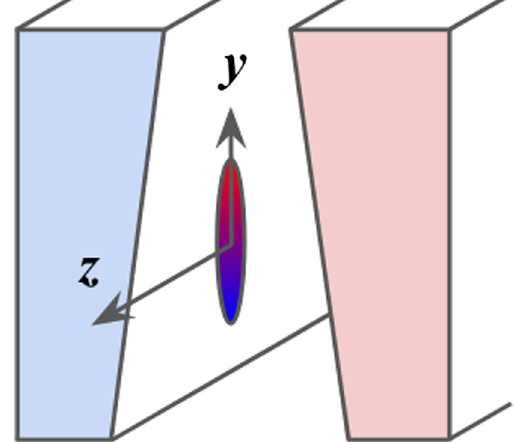
above.FIG. 1. Cross section of a transverse gradient undulator (TGU) aligned vertically. The direction of electron motion is in z . The magnetic field gradient grows stronger along the positive y axis due to the canted undulator poles (exaggerated for visibility). If the electron bunch (center oval) is dispersed appropriately so that higher energy electrons (red; top half) experience higher field strength while lower energy electrons (blue; bottom half) expe- rience less, then FEL gain can be greatly improved even for large electron energy